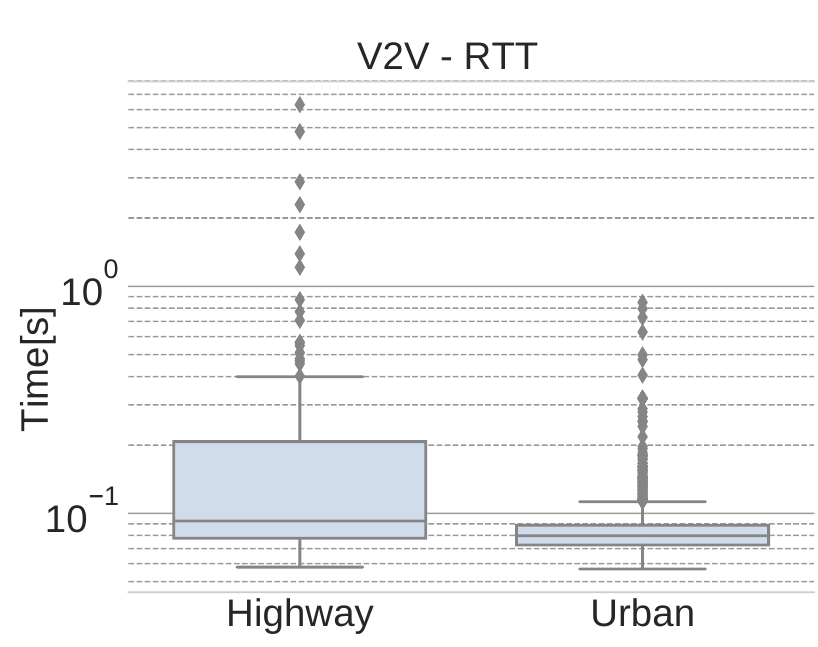
Figure 14. Network packet round-trip time (RTT) from vehicle to vehicle (V2V) experiments.